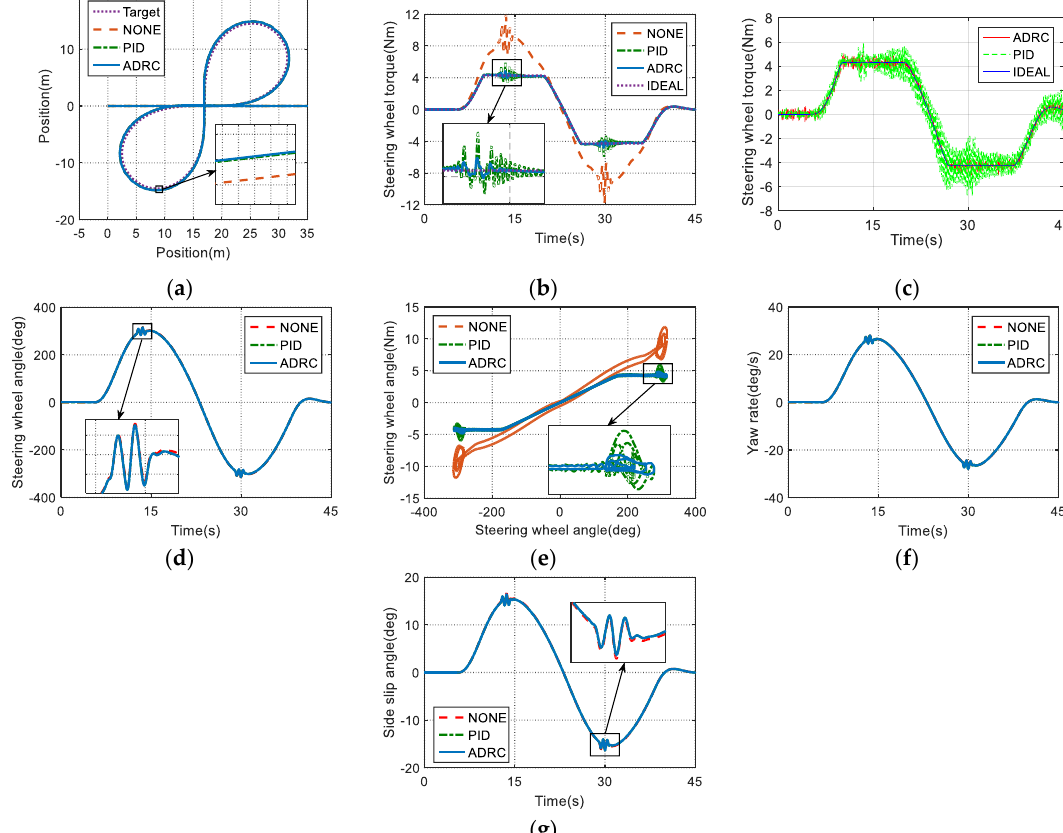
Figure 12. Closed-loop lemniscate simulation: ( a ) Vehicle trajectory; ( b ) Steering wheel torque; ( c ) Steering wheel torque with white noise; ( d ) Steering wheel angle; ( e ) Cross-plot of steering wheel angle and torque; ( f ) Yaw rate; ( g ) Side slip angle.